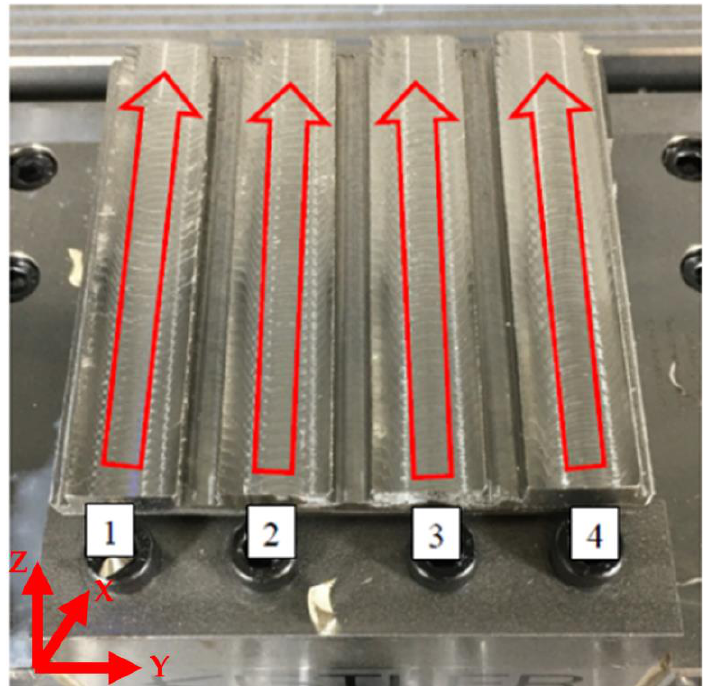
Figure 3. Manner of machining and orientation of cutting